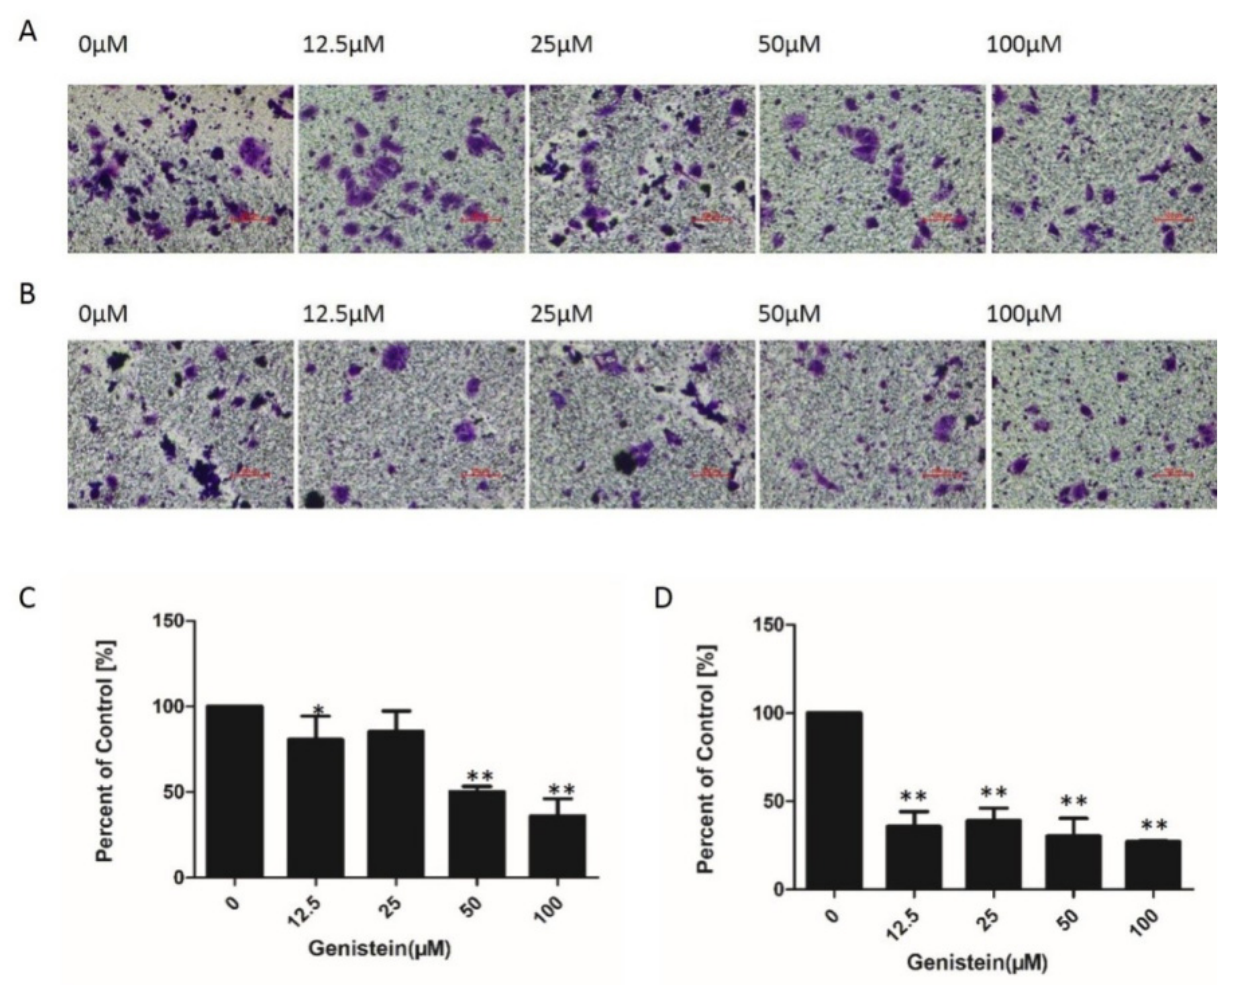
Figure 9. Effect of genistein on the migration and invasion activities of HeLa cells. Cells were seeded on membranes and co-cultured with different doses of genistein for 24 h. ( A ) Cells that migrated to the lower surface of the filter were fixed and stained with crystal violet, and then photographed by an inverted microscope at × 100. ( B ) Cell invasion was assessed by following cell movement through the Matrigel to the lower surface of the filter. Invading cells were fixed, stained with crystal violet, and photographed under an inverted microscope at ×100. ( C ) Cell migration was quantified from at least three images randomly using Image J software. ( D ) Cell invasion was quantified from at least three images randomly using the Image J software. The experiment was repeated three times. ** p < 0.01 vs. DMSO control. * p < 0.05 vs. DMSO control; scale bar: 200 μ m.